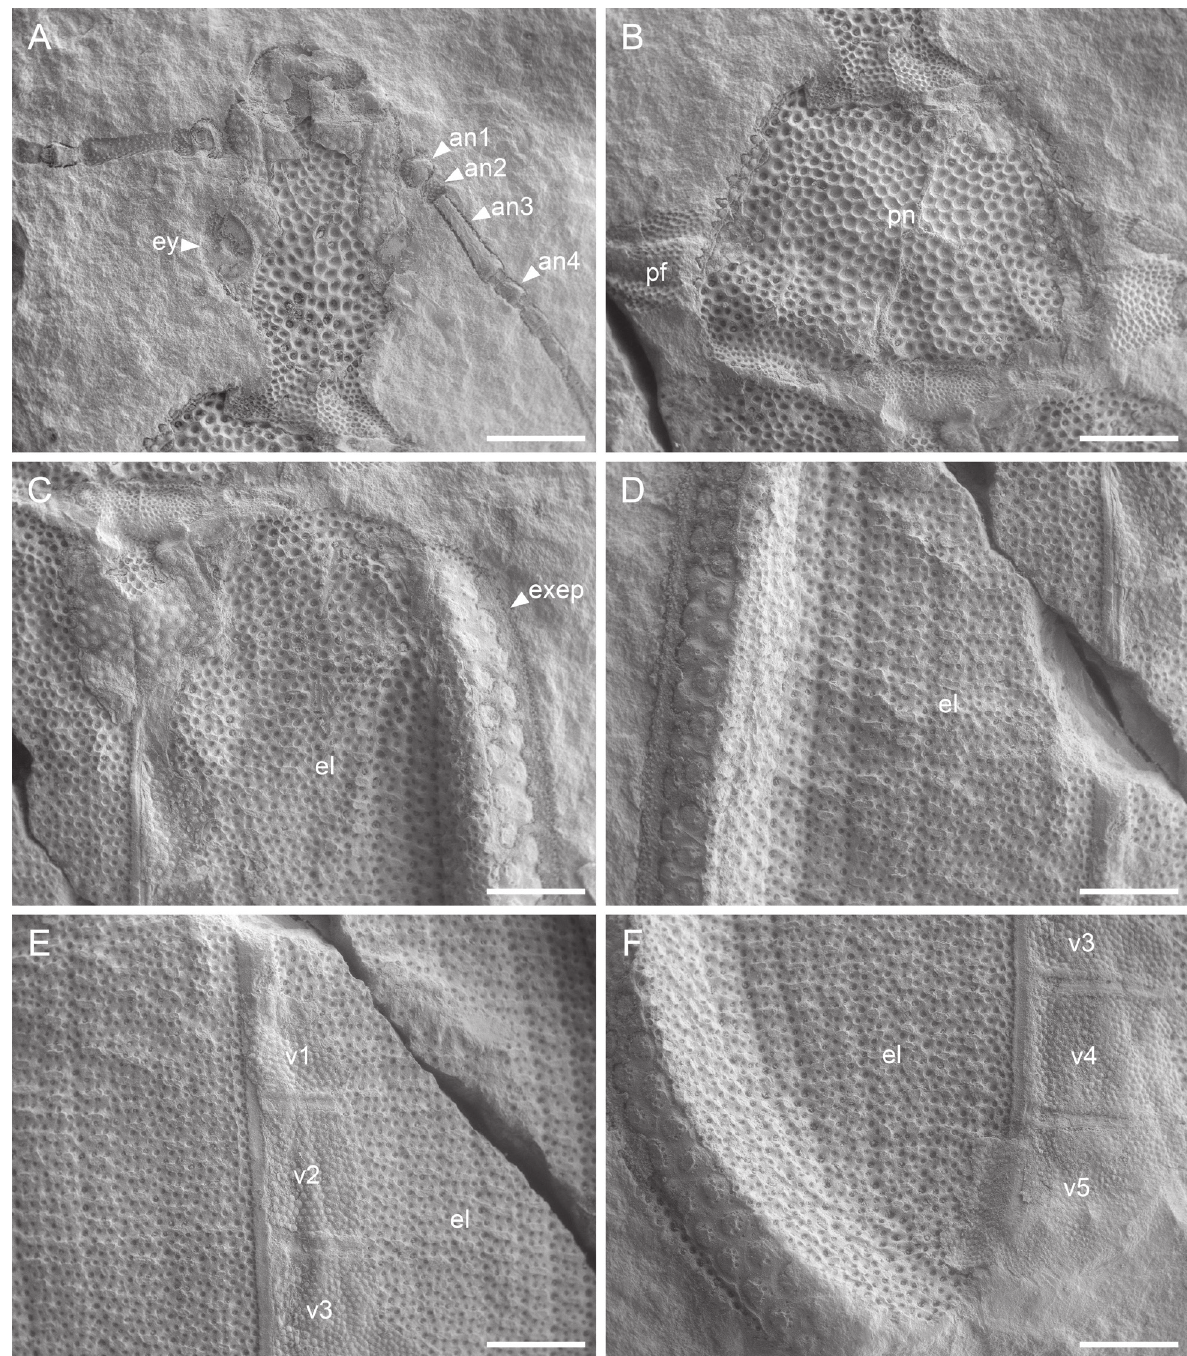
Figure 3. Details of Limnomma daohugouense gen. et sp. nov., holotype, NIGP176015a, under scanning electron microscopy. A. Head; B. Prothorax; C. Elytral base; D. Middle part of elytra; E. Elytra, with carbon film of abdominal ventrites partially showing; F. Elytral apex. Abbreviations: an1–4, antennomeres 1–4; el, elytron; exep, explanate epipleuron; ey, compound eye;